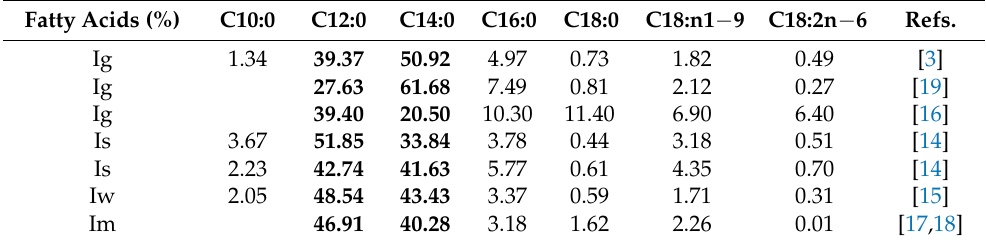
Table 2. Fatty acid profile of Irvingiaceae species